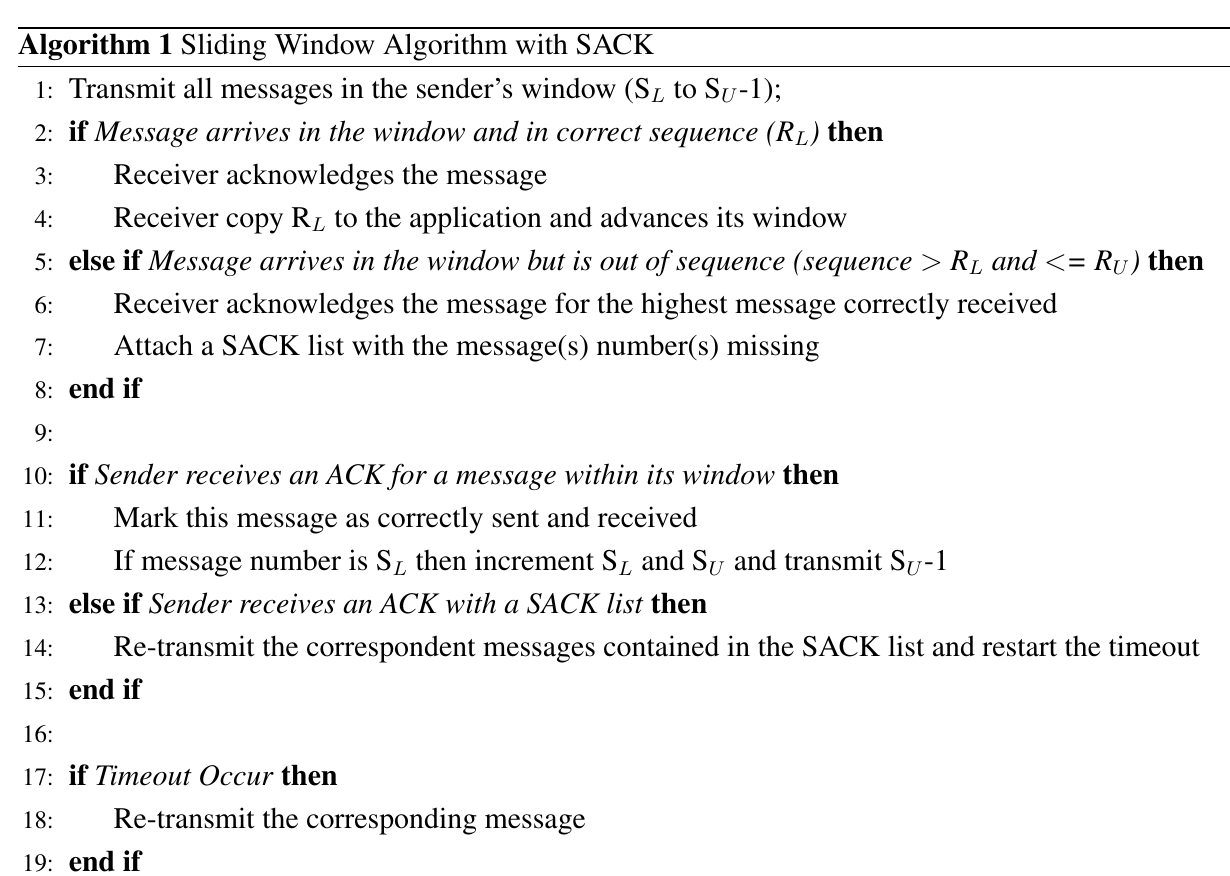
Algorithm 1 Sliding Window Algorithm with SACK